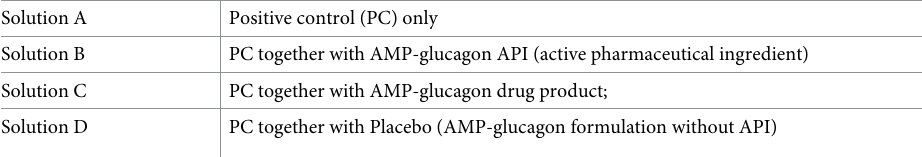
Table 5. Solution types used for immunogenicity mask assessment